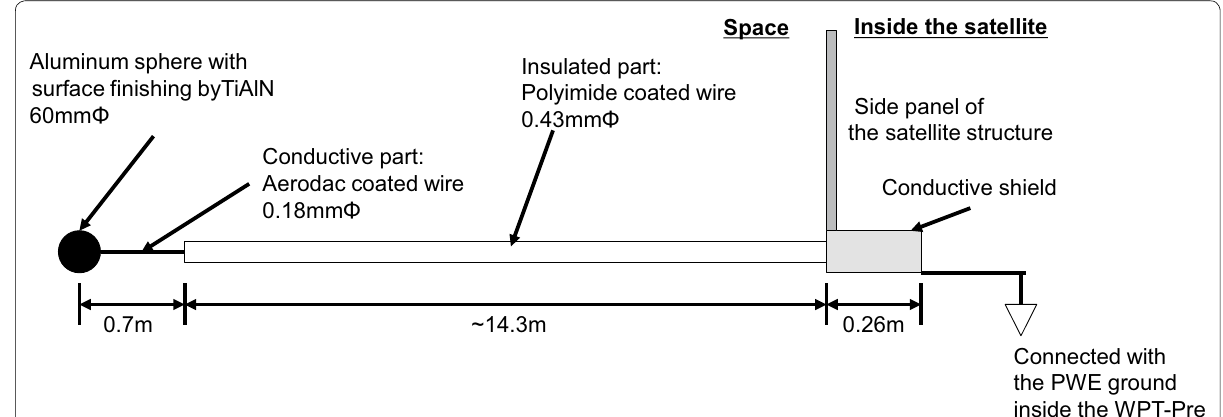
Fig. 6 WPT-S configuration. The total length is 15 m, and a 60-mm-diameter sphere is attached to the end of a sensor wire. Apart from the upper 70 cm, the wire is covered by polyimide